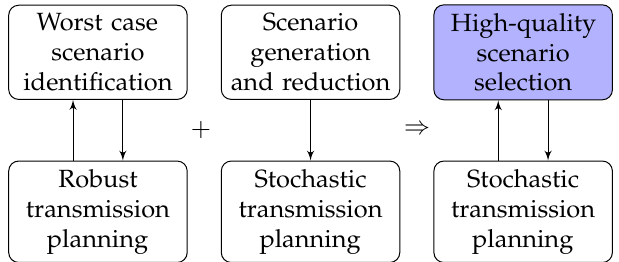
Figure 1. Conceptual differences among robust transmission expansion planning (TEP) ( left ), stochastic TEP ( middle ), and the iterative stochastic TEP ( right )